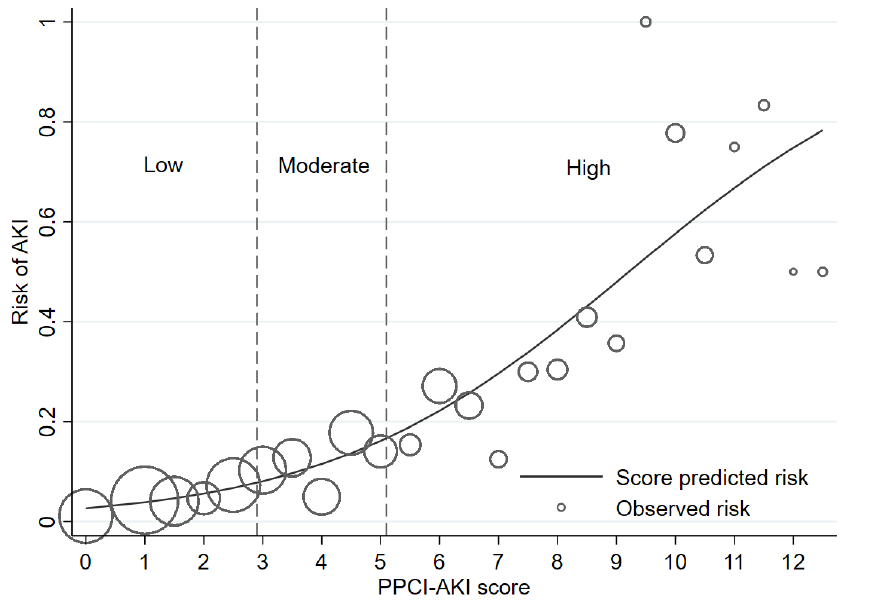
Figure 4. Predicted risk AKI by score (solid line) and observed risk of AKI (hollow circles). Size of circles depicts relative number of patients in each score. Abbreviations: AKI, acute kidney injury. Table 3. Distribution of AKI, non-AKI, and likelihood ratio of AKI (LHR+) in low-, moderate-, and high-risk categories. Risk